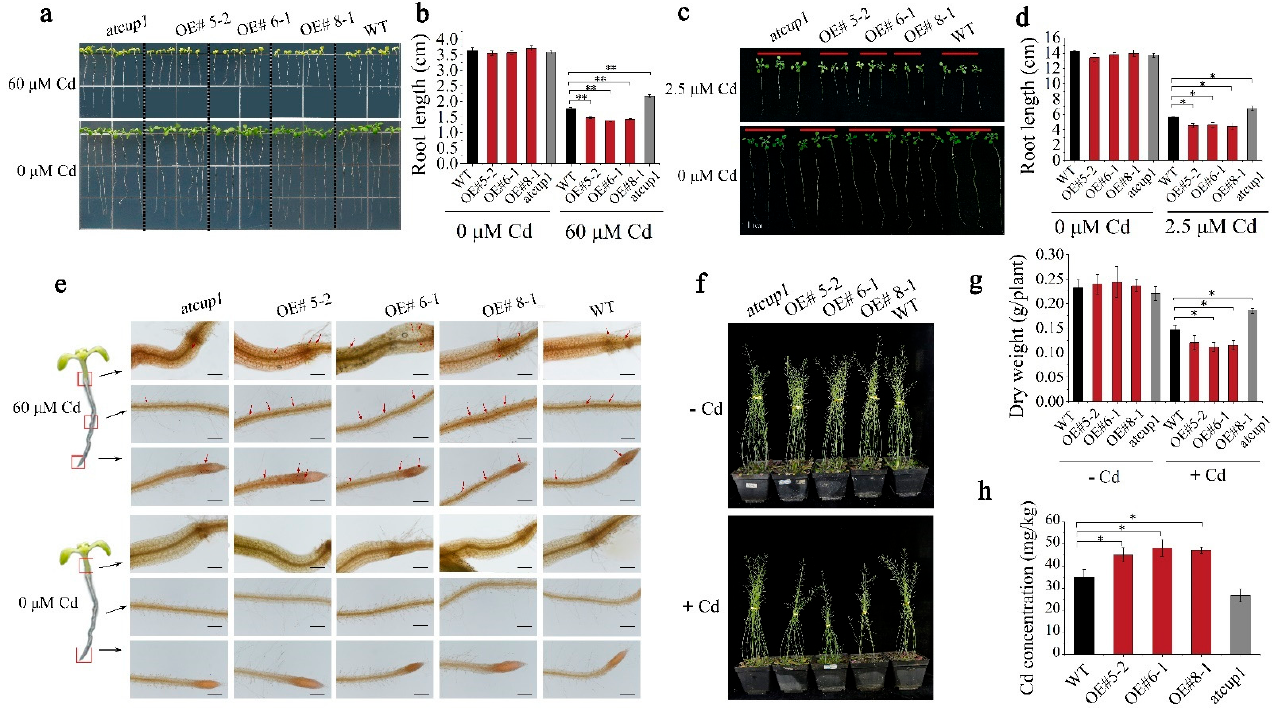
Figure 3. AtCUP1 contributes to Cd absorption and accumulation in A. thaliana . ( a ) Growth status of three A. thaliana lines growing on 1/2 MS medium, containing 0 or 60 µ M Cd. ( b ) Root length measurements of three A. thaliana lines in ( a ). growth status ( c ) and root length measurements ( d ) of A. thaliana cultured in hydroponic solution containing 0 or 2.5 µ M Cd. ( e ) Visualization of Cd accumulation in the A. thaliana hypocotyl exposed to 0 or 60 µ M Cd. The red arrows point to the precipitates of Cd-dithizone. Bars indicate 500 µ m. ( f ) Growth status of three A. thaliana lines at harvest, growing in Cd-contaminated pot soil. ( g , h ) Dry weight and Cd concentration of three A. thaliana lines with and without Cd treatment. All data were obtained from three independent triplicate experiments and the error bar represents standard deviation. Statistical analysis was performed by Student’s t- test (* p < 0.05, ** p <